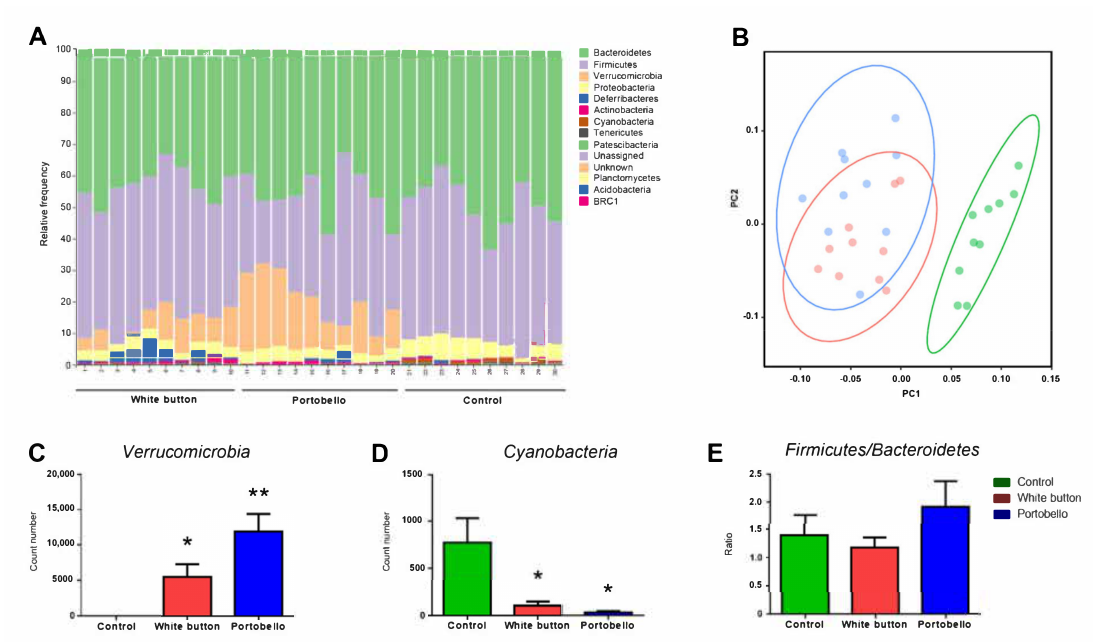
Figure 2. Relative frequency of bacteria at the phylum level. A general comparison of all phyla in the experimental animals fed with the white button diet (1–10), Portobello diet (11–20), or basic diet (21–30) shows a clear upregulation of Verrucomicrobia (orange) associated with the diets ( A ). A principal component analysis shows a marked difference between the control diet (green) and the other two diets ( B ). Quantification of Verrucomicrobia ( C ) and Cyanobacteria ( D ) shows also clear differences with the control diet. There were no significant differences in the Firmicutes/Bacteroidetes ratio ( E ). Bars represent the mean and standard error of the mean (SEM) of all measurements ( n = 10). *: p < 0.05 and **: p < 0.01 versus control.